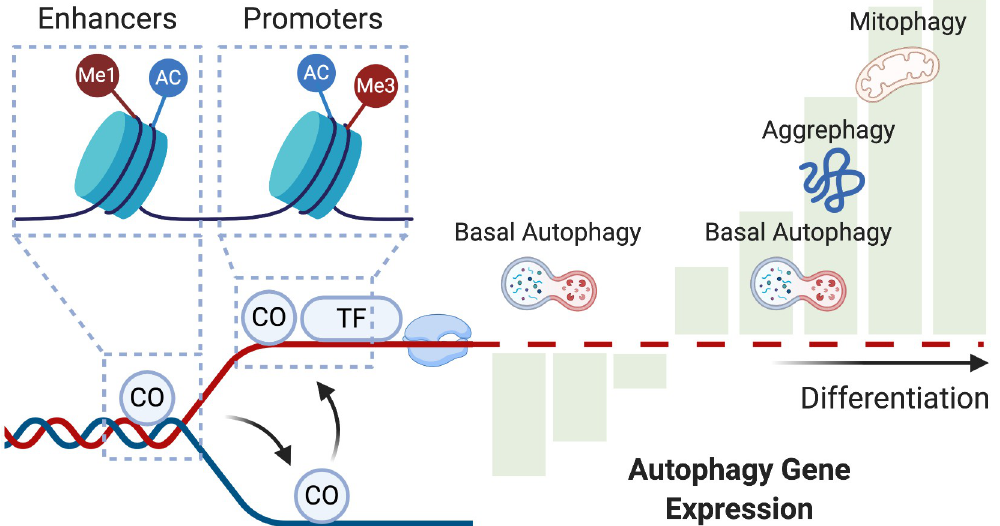
Fig 6. A model for transcriptional and chromatin modification on autophagy genes. Co-factors (CO) precede transcription factors (TF) to their shared targets. Co-regulators localize to enhancer regions marked by lysine monomethylation (Me1) and acetylation (Ac). They prime the targets for transcription, where transcription factors bind to the promoter regions marked by lysine tri-methylation (Me3) and acetylation (Ac). These events regulate the expression of autophagy genes in a bi-phasic manner. Early during adipogenesis, several autophagy genes are down-regulated, and possibly only basal autophagy is functional. Later, autophagy genes are up-regulated, and autophagy, organelle-specific autophagy, in particular, is